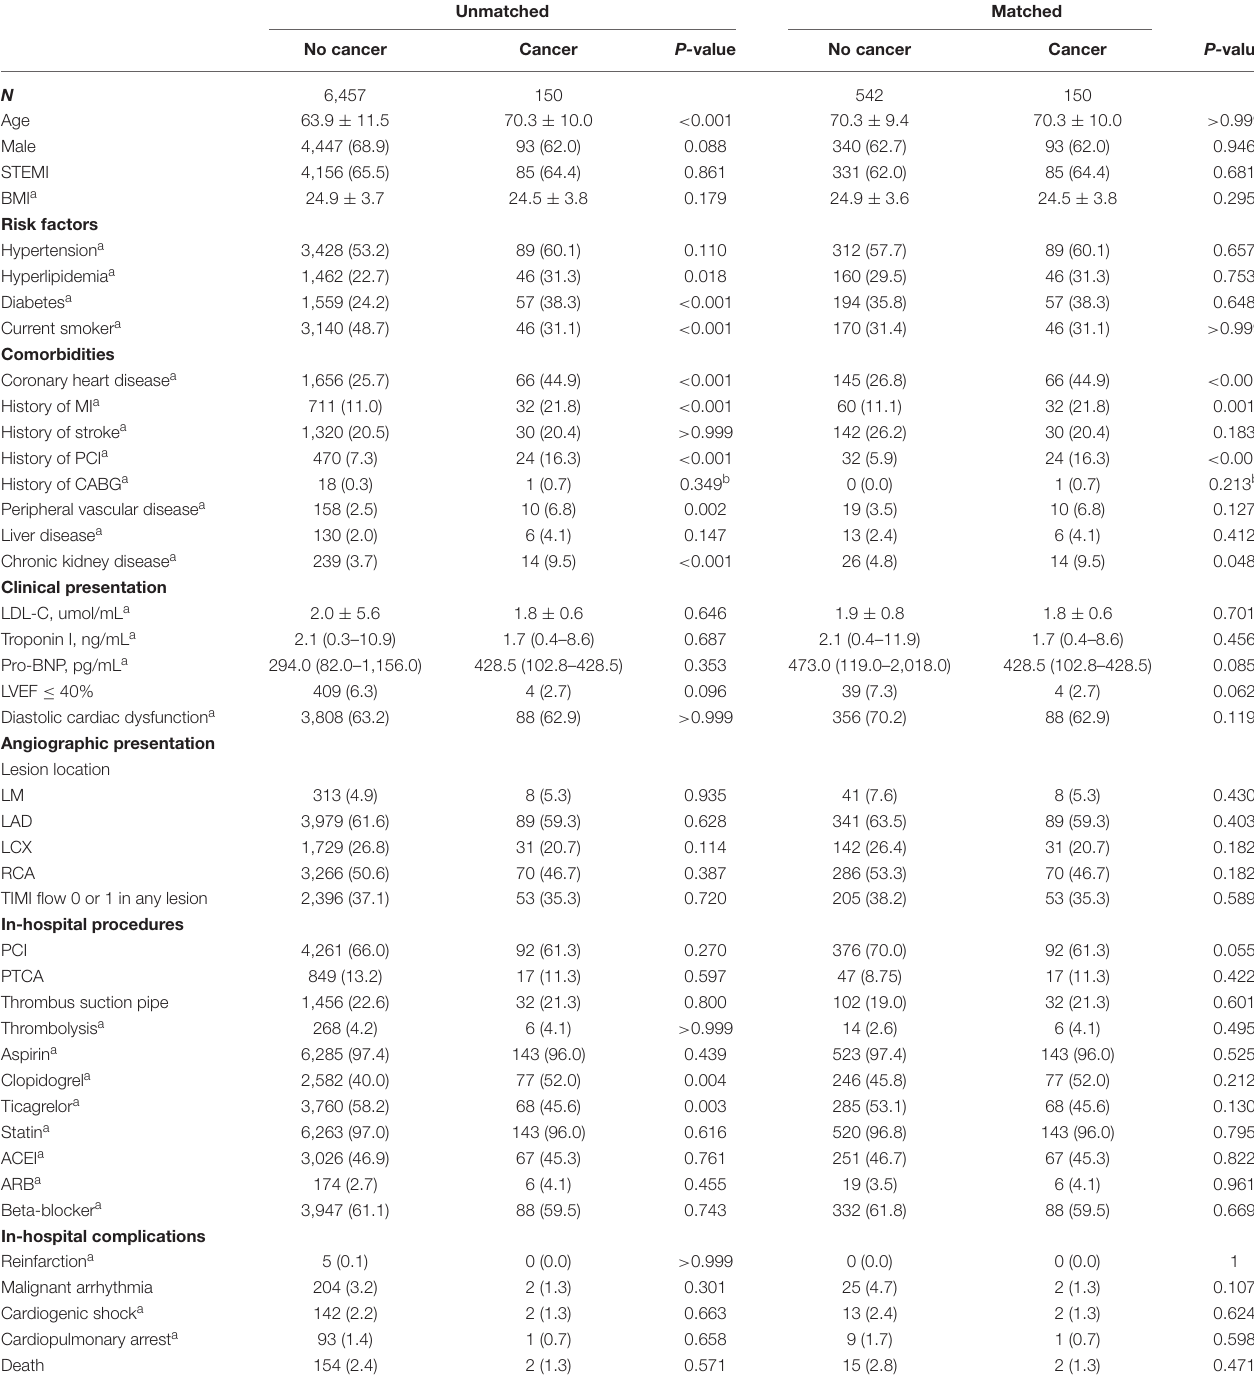
TABLE 1 | Clinical